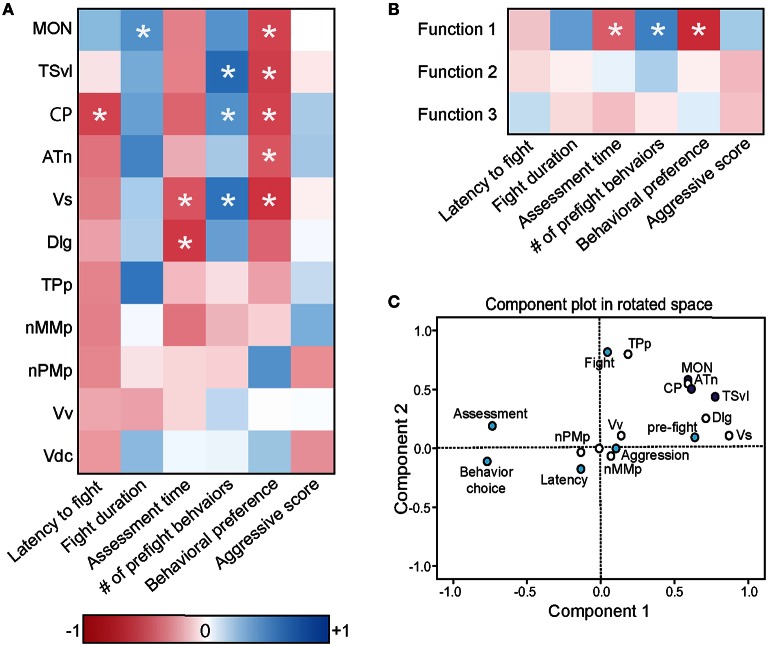
Brain cfos staining correlates with fight and assessment behaviors. (A) Heat map of Pearson correlation coefficients (R = color scale) of cfos staining in brain nuclei with behaviors (see also Table 4). (B) Heat map of Pearson correlation coefficients of the CDA functions with behaviors. Function 1 (loaded primarily by the MON, TSvl, ATn, Dlg, and Vs) separated lateral line-intact and -ablated animals. Function 2 (loaded primarily by the TSvl, MON, nMMp, nPMp, ATn, Vdc, and Vv) separated fight winners and losers. Function 3 was equally loaded by all brain regions. (C) Principal component analysis of cfos staining in sensory processing regions (purple dots), social behaviors (white dots), and fight and assessment behaviors (blue dots). *P < 0.05. See list for abbreviations. Aggression: aggressive score during territorial interaction. Assessment: % of prefight time spent within one body length of opponent. Behavior choice: ratio of contact to non-contact fight behaviors. Fight: fight duration. Latency: latency to fight. Pre-fight: number of unreciprocated prefight aggressive behaviors.